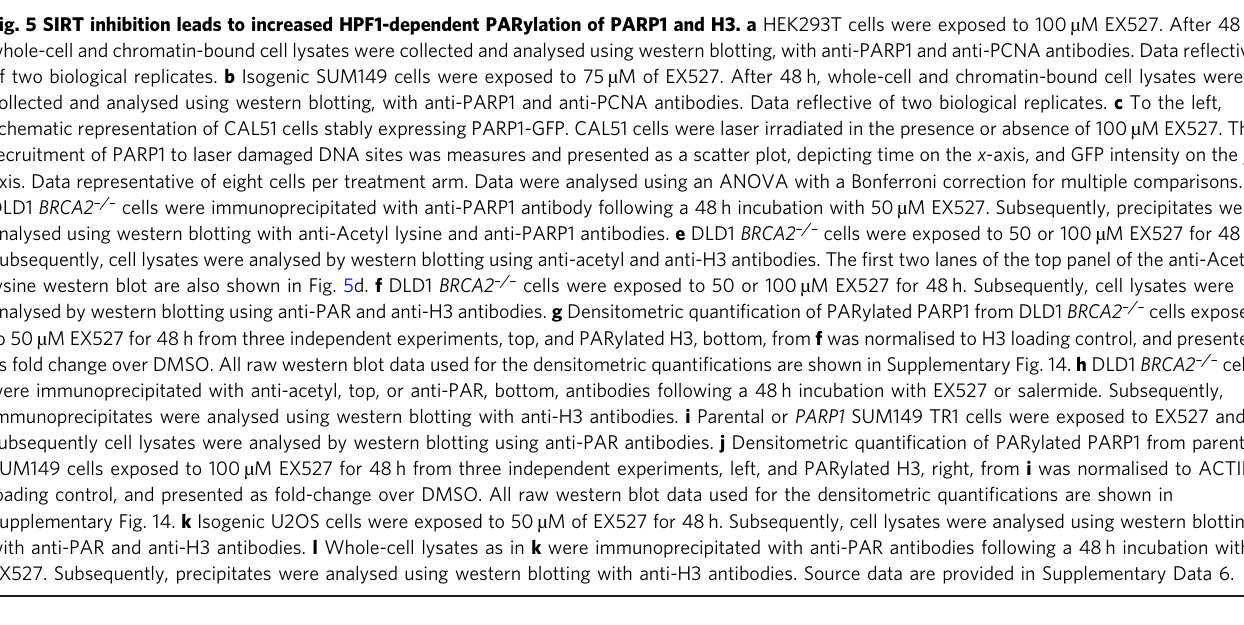
Fig. 5 SIRT inhibition leads to increased HPF1-dependent PARylation of PARP1 and H3. a HEK293T cells were exposed to 100 µ M EX527. After 48 h, whole-cell and chromatin-bound cell lysates were collected and analysed using western blotting, with anti-PARP1 and anti-PCNA antibodies. Data re fl ective of two biological replicates. b Isogenic SUM149 cells were exposed to 75 µ M of EX527. After 48 h, whole-cell and chromatin-bound cell lysates were collected and analysed using western blotting, with anti-PARP1 and anti-PCNA antibodies. Data re fl ective of two biological replicates. c To the left, schematic representation of CAL51 cells stably expressing PARP1-GFP. CAL51 cells were laser irradiated in the presence or absence of 100 µ M EX527. The recruitment of PARP1 to laser damaged DNA sites was measures and presented as a scatter plot, depicting time on the x -axis, and GFP intensity on the y - axis. Data representative of eight cells per treatment arm. Data were analysed using an ANOVA with a Bonferroni correction for multiple comparisons. d DLD1 BRCA2 – / – cells were immunoprecipitated with anti-PARP1 antibody following a 48 h incubation with 50 µ M EX527. Subsequently, precipitates were analysed using western blotting with anti-Acetyl lysine and anti-PARP1 antibodies. e DLD1 BRCA2 – / – cells were exposed to 50 or 100 µ M EX527 for 48